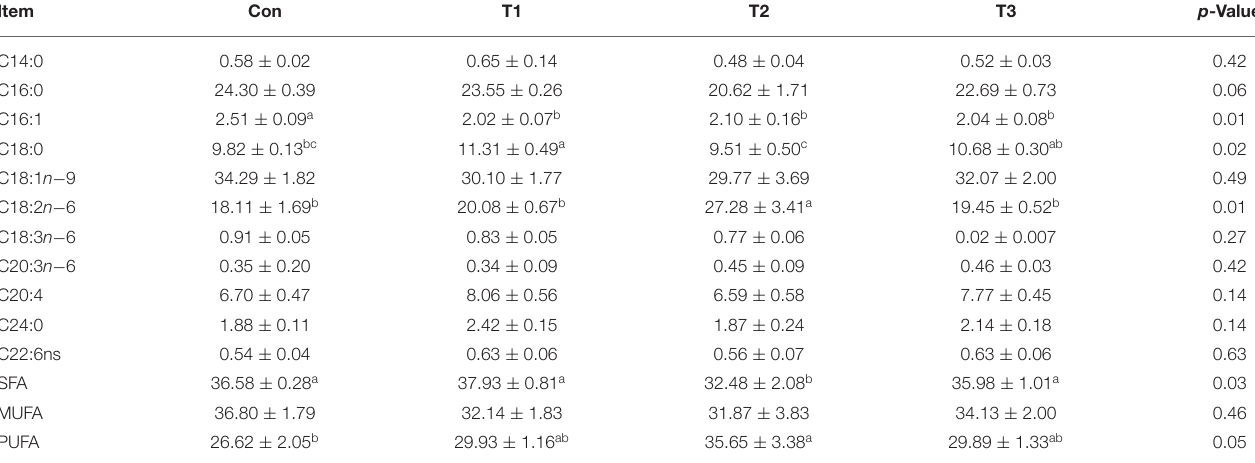
TABLE 6 | Effects of dietary supplementation with Elephantopus scaber on fatty acid contents in breast muscle